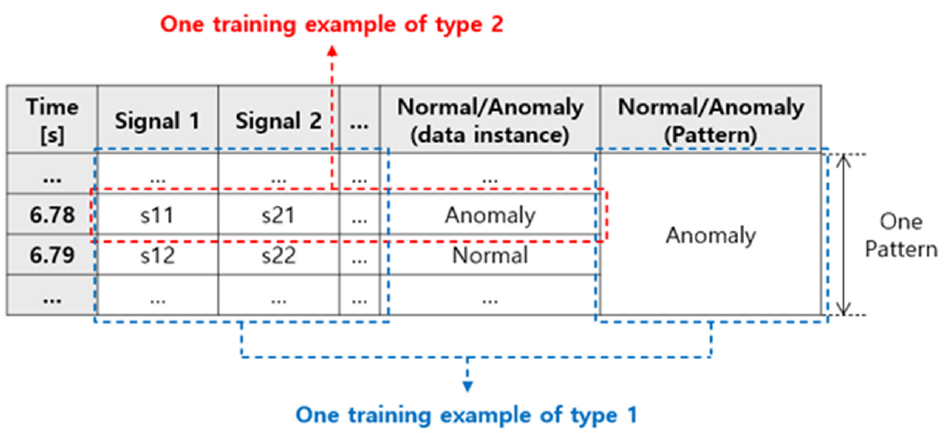
Figure 12. An example of one training example for each input/output data structure type.